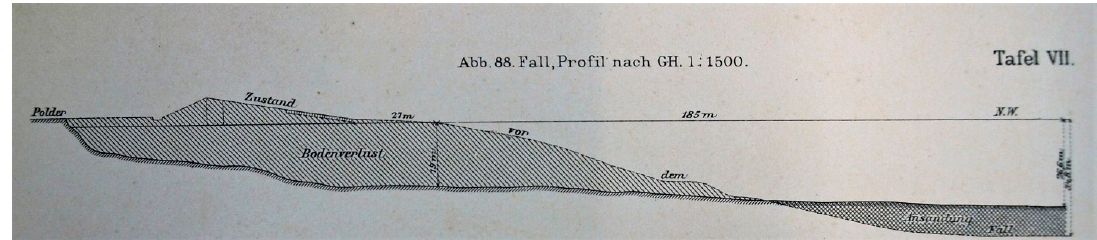
Figure 6. Cross section of 1881 flow slide at Oud Noord-Beveland Polder, Zeeland. Original figure of Fr. Müller, W. Ernst Verlag, Berlin, 1898 [14]. Compare Figure 5. For location, see Figure 7.